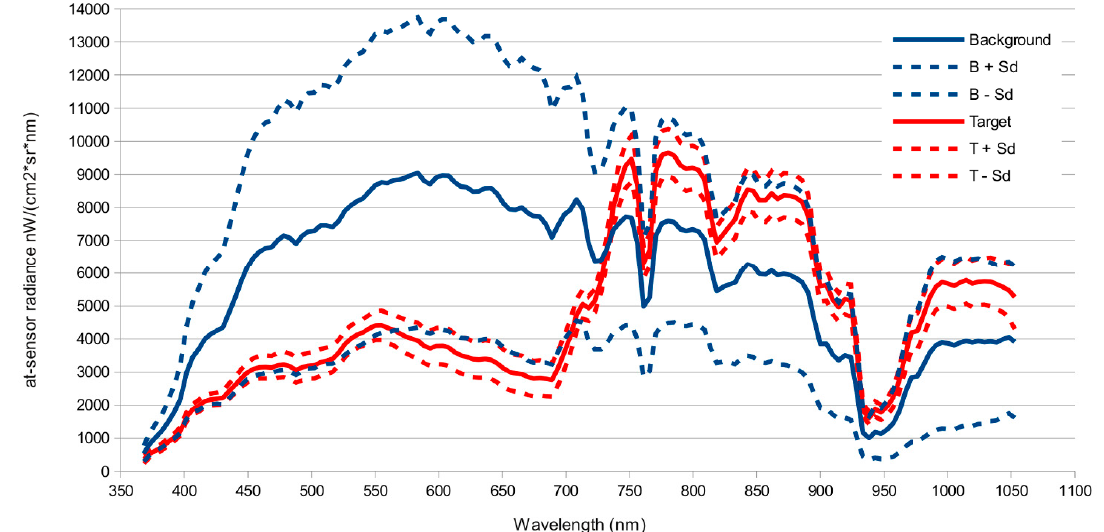
Figure 2. Mean ± s.d. of target and background radiance spectra as extracted from the CASI image.